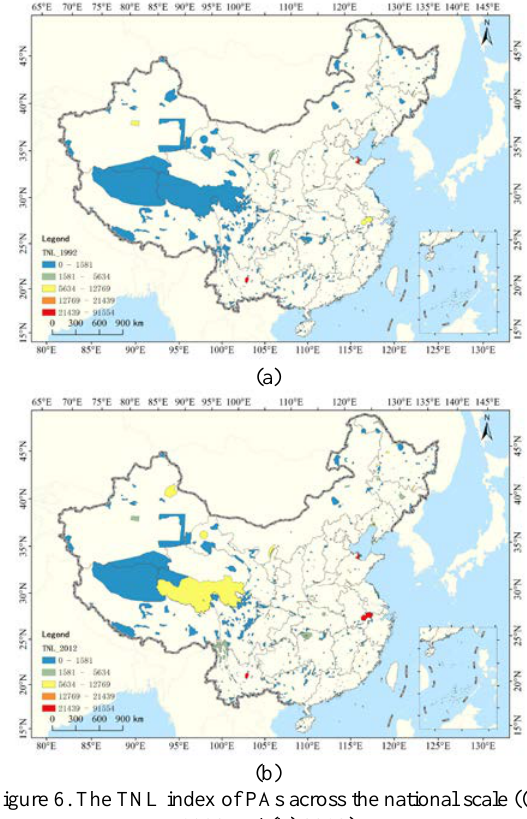
Figure 6. The TNL index of PAs across the national scale ((a) 1992 and (b) 2012)